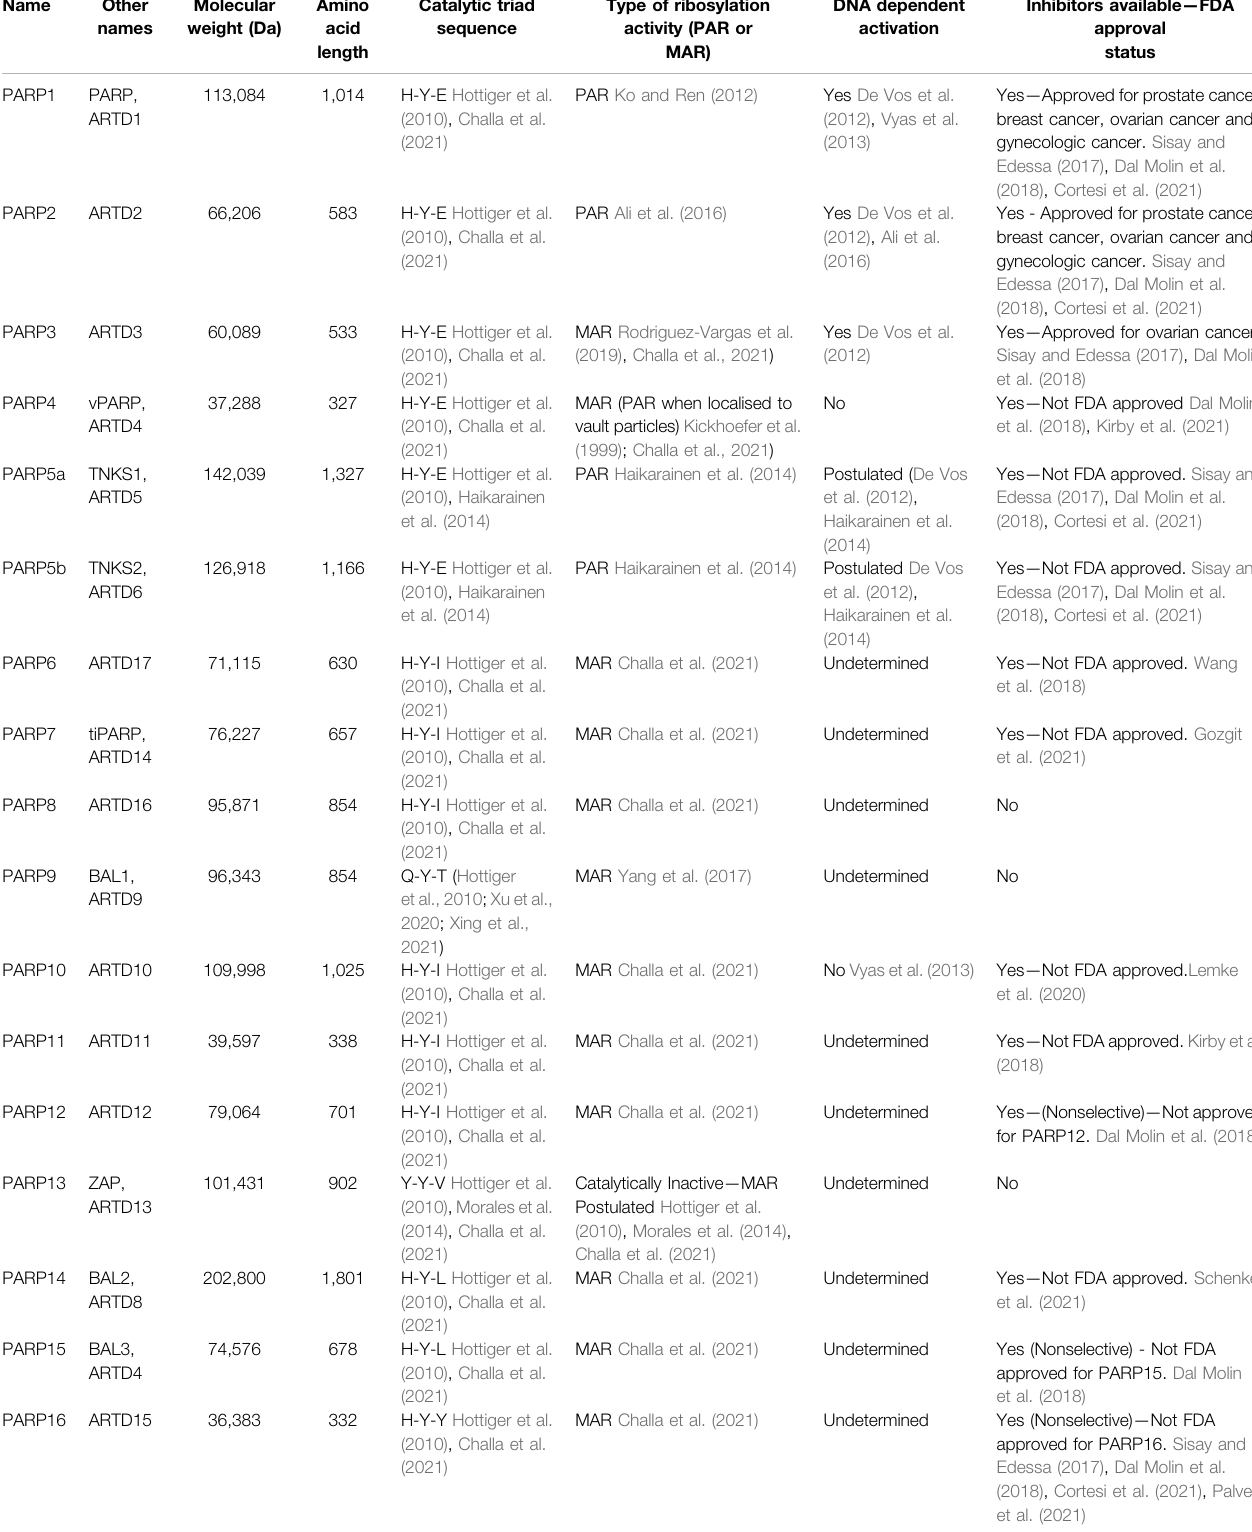
TABLE 1 | Overview of PARP family structure and basic